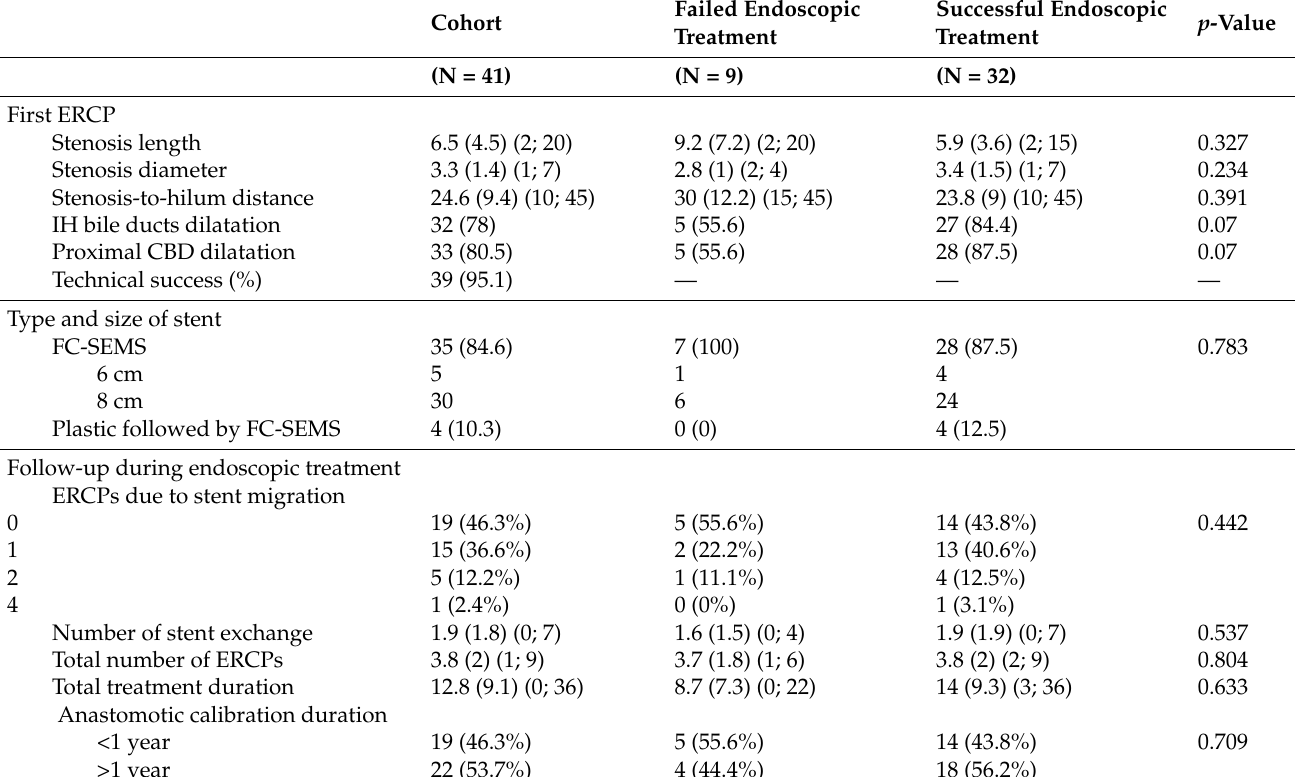
Table 3. Endoscopic